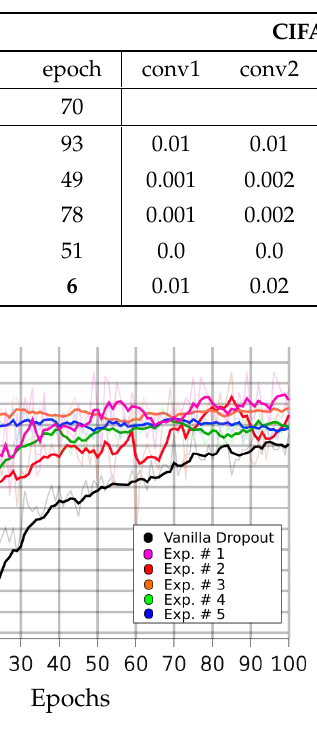
Table 1. Accuracy scores, parameter tuning, and convergence times for different experiments on the CIFAR10 dataset. The first row holds the best accuracy score for the vanilla dropout version and the epoch at which it was attained.